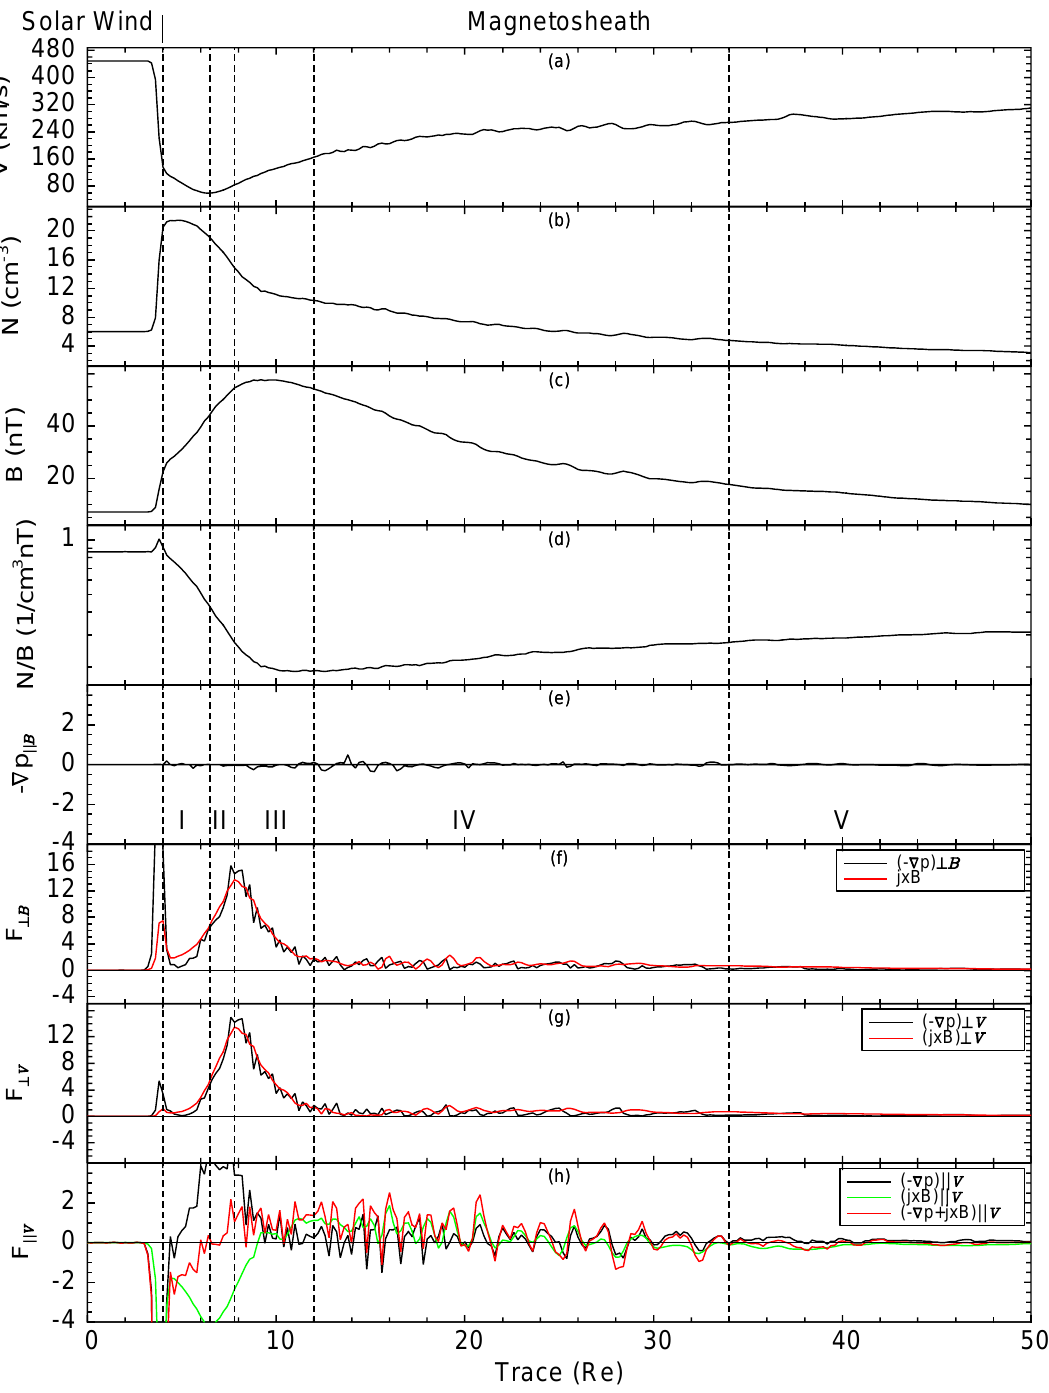
Fig. 10. Forces in a streamline coordinate system along streamline 0 in the left panel of Fig. 8, together with plasma and field parameters. From top to bottom are: the flow velocity, the plasma density, the magnetic field magnitude, the N/B ratio, the pressure gradient force parallel to magnetic field, the forces perpendicular to magnetic field, the forces perpendicular to the flow velocity, and the forces parallel to the flow velocity. The unit of the forces in panels (e)–(h) is 10 − 17 Pascal/m. The horizontal axis is the distance along the streamline from its starting point in the solar wind. Panels (f) and (g) are drawn with the same scale, but panels (e) and (h) are drawn with a smaller scale and thus the values are more